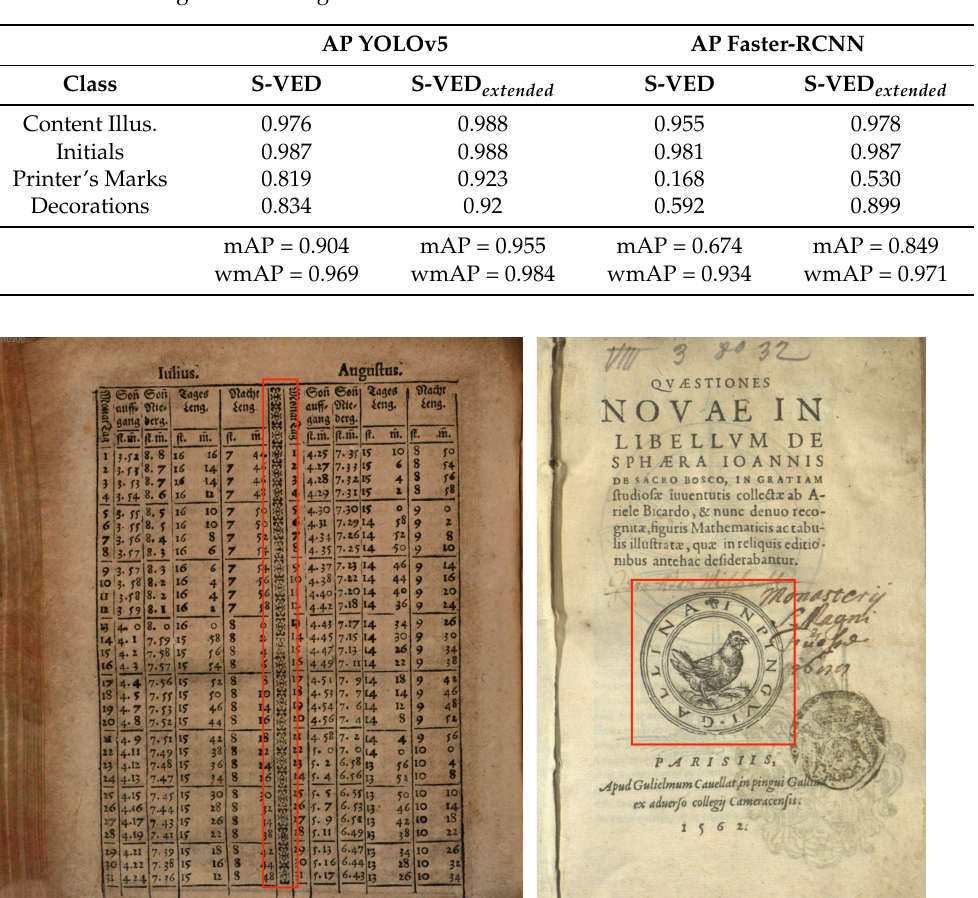
Figure 3. Classification Errors. ( Left ) False Negative: the model failed to recognize a dec- oration visual item embedded within a numerical table ( Sphaera , 1614, Leipzig, https://hdl. handle.net/21.11103/sphaera.101208, accessed on 2 October 2022, Bayerische Staatsbibliothek. urn:nbn:de:bvb:12-bsb11110900-6); ( Right ) Class misclassification: the model classified the